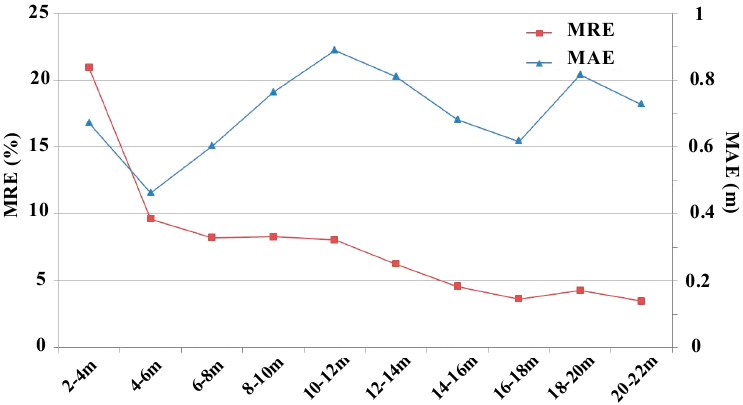
Figure 13. Mean absolute error (MAE) and mean relative error (MRE) of specific depth ranges of control points.